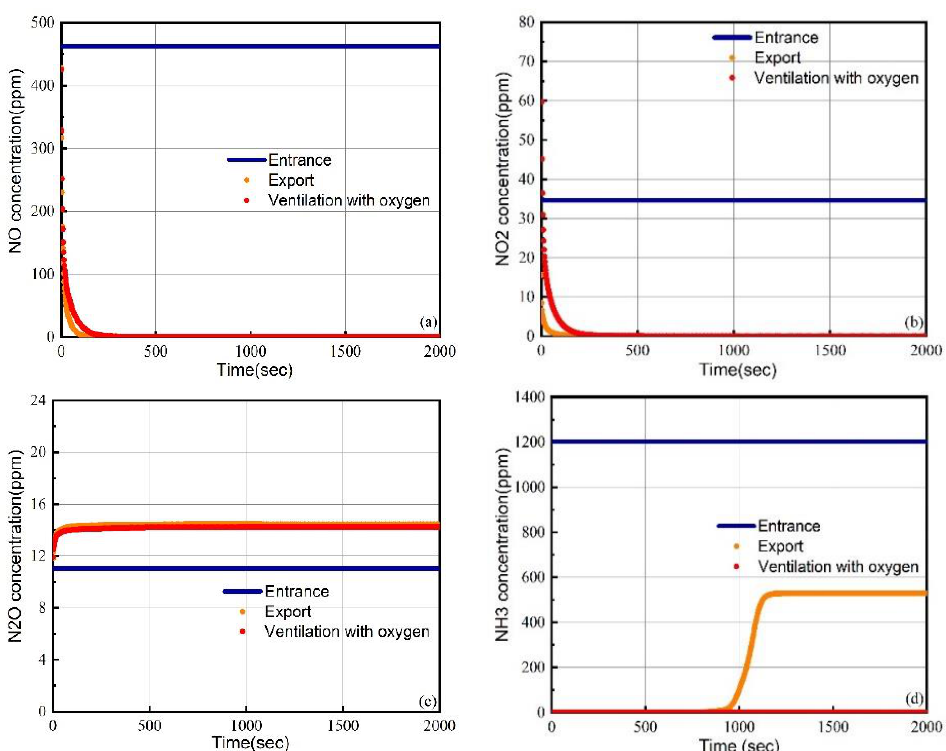
Figure 11. Changes in NOx and ammonia concentrations at the inlet and outlet of the SCR model before and after oxygen was introduced in Case 2. ( a ) NO concentration on entrance, export and ventilation with oxygen. ( b ) NO 2 concentration on entrance, export and ventilation with oxygen. ( c ) N 2 O concentration on entrance, export and ventilation with oxygen. ( d ) NH 3 concentration on entrance, export and ventilation with oxygen.